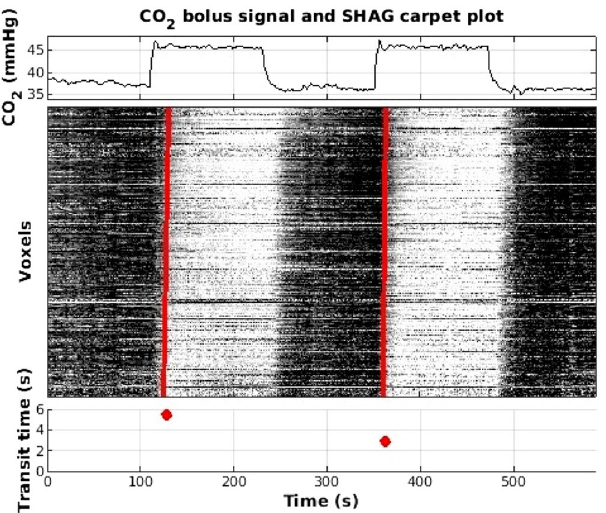
Figure 5. Preliminary example of SHAG carpet plot and transit time computation based on CO 2 challenge scan. (Top) CO 2 intensity, given in mmHg, administered to subject for inhalation during rs-fMRI scan. (Middle) SHAG carpet plot (with noisy voxels cropped) constructed by ordering voxels according to delay times computed via cross correlation of voxel BOLD signal with CO 2 bolus signal from upper plot. (Bottom) Transit times computed for detected slopes corresponding to blood arrival.